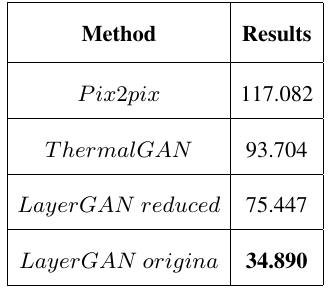
Table 1. The results of evaluation using FID